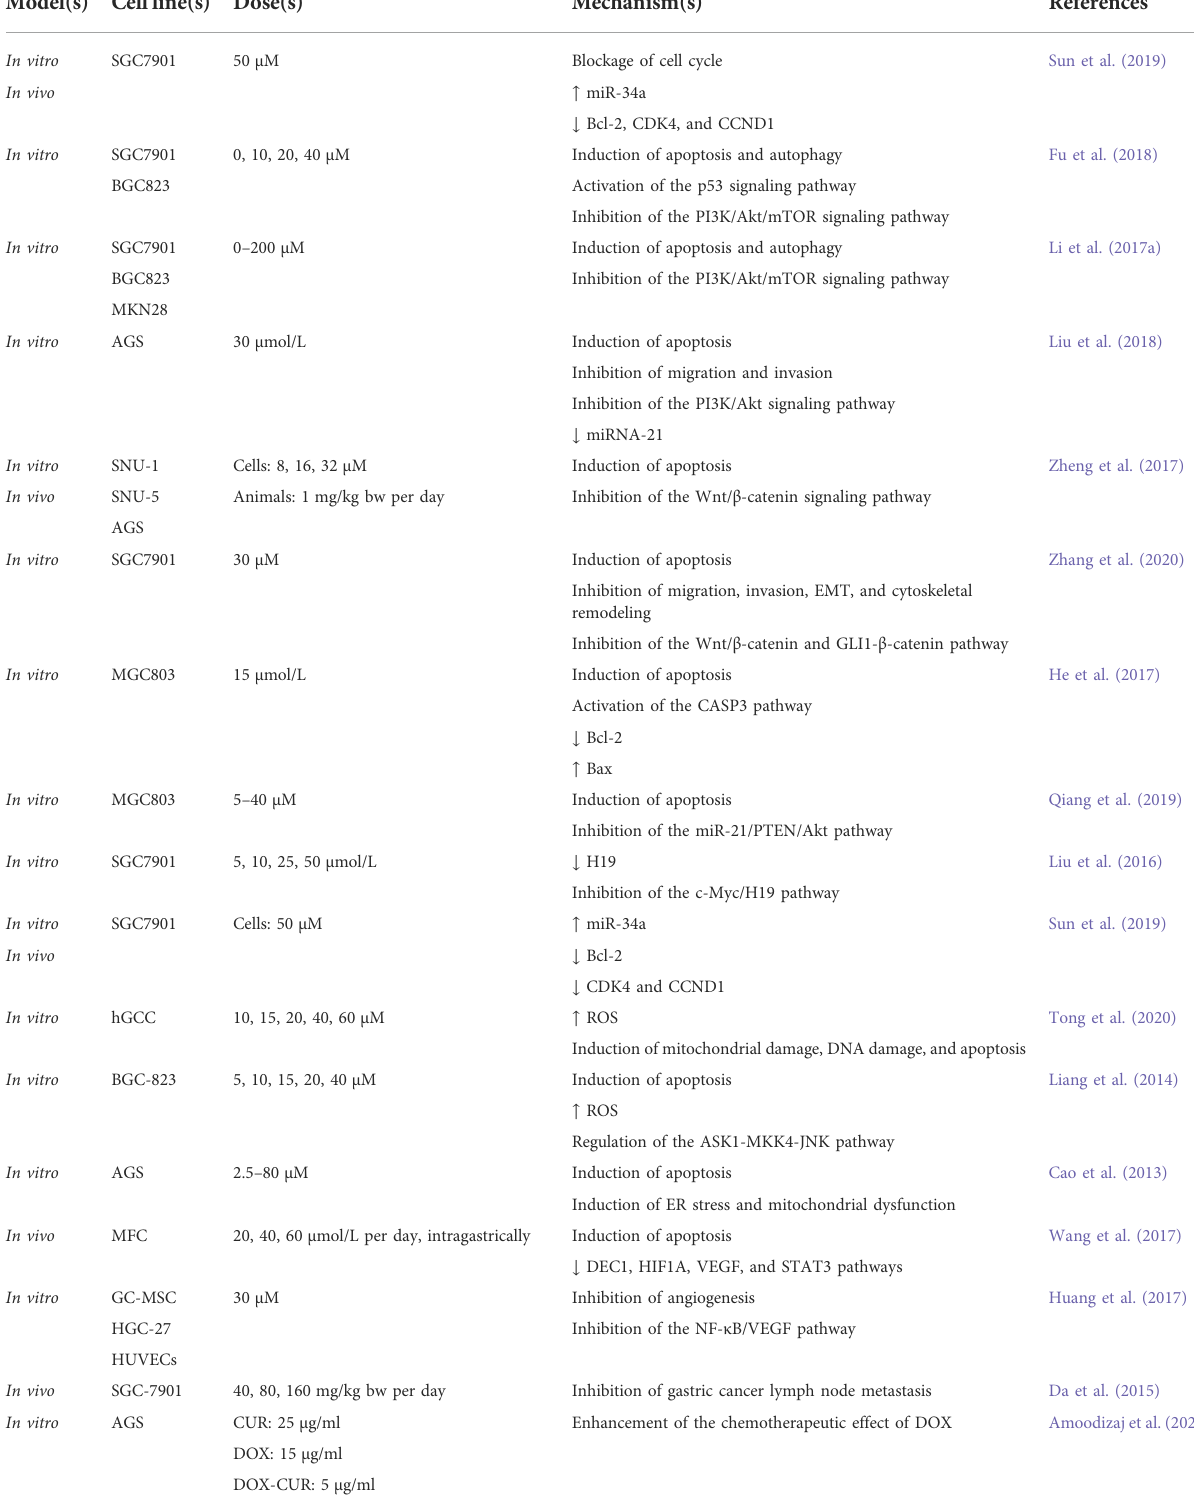
TABLE 1 Pharmacological mechanism underlying the effects of curcumin on gastric